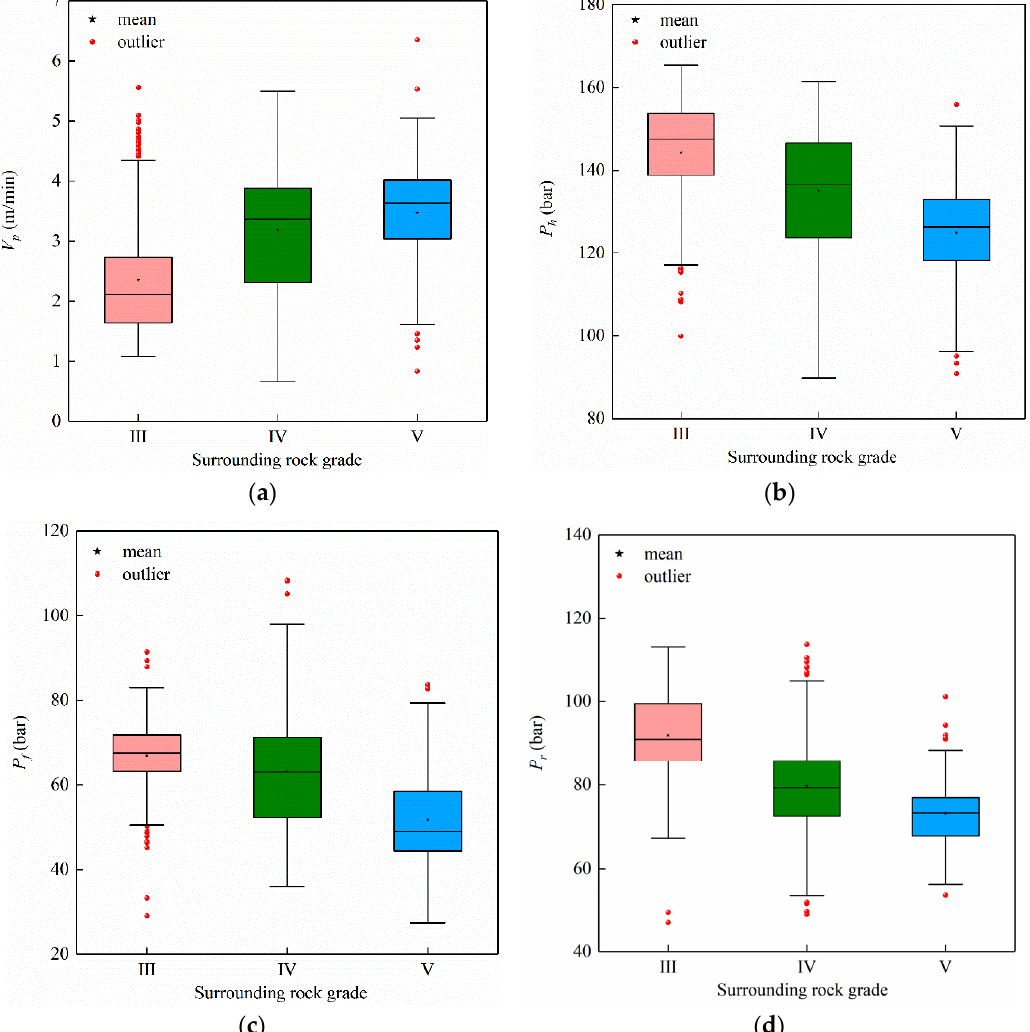
Figure 6. Drilling parameter box diagrams for each surrounding rock grade. ( a ) Penetration velocity ( V p , m/min); ( b ) hammer pressure ( P h , bar); ( c ) feed pressure ( P f , bar); ( d ) rotation pressure ( P r , bar).